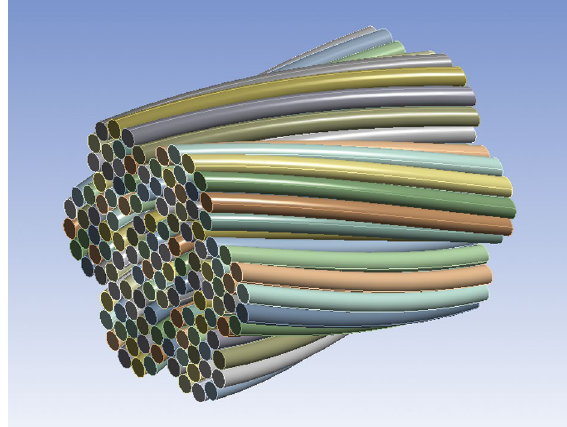
Fig. 4. 7 × 19 stainless steel wire